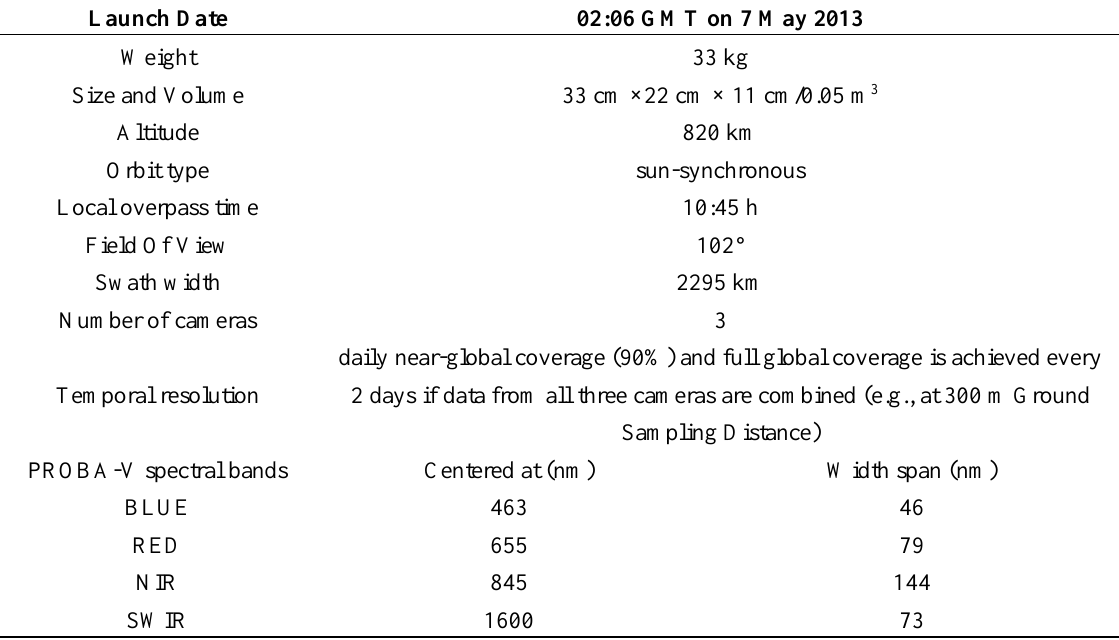
Table 2. PROBA-V mission main characteristics.